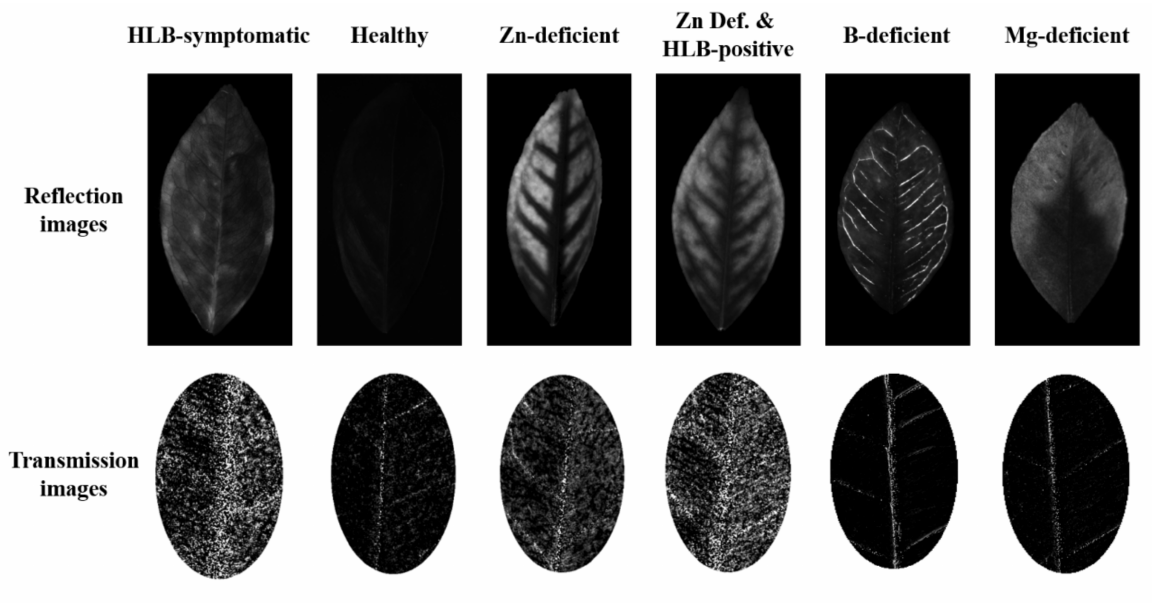
Figure 2. Example images of different types of leaves acquired using the custom-developed vi- sion